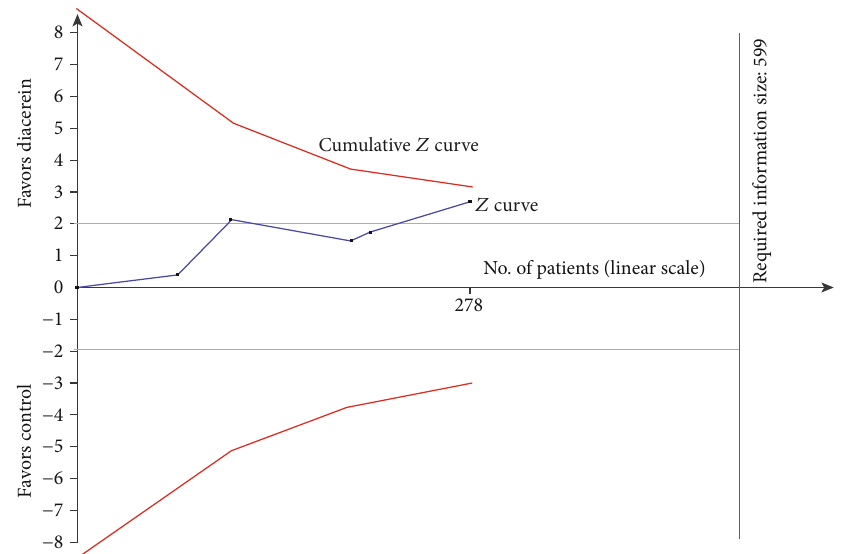
Figure 4: Trial sequential analysis of the pooled outcome regarding fasting blood glucose. A trial sequential analysis (TSA) showed that the pooled results ( Z curve; blue lines) crossed the conventional boundary of bene fi t (celeste line) but did not reach the required information size (599) or cross the trial sequential monitoring boundary for bene fi t (cumulative Z curve in red) to enter the area of bene fi t (above the upper red